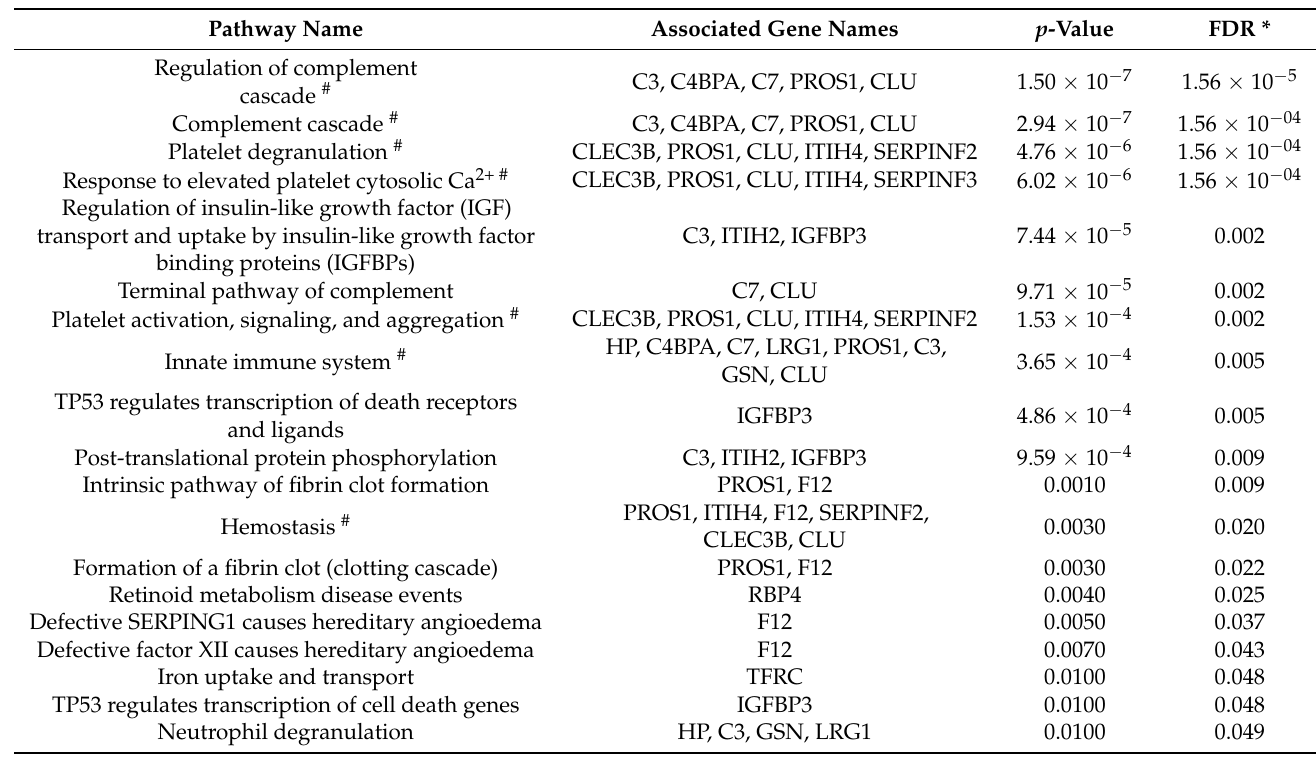
Table 2. Pathway enrichment analysis of serum proteins differentially abundant between groups with different MMVD stages and the healthy/control group ( p < 0.05, FDR < 0.05).